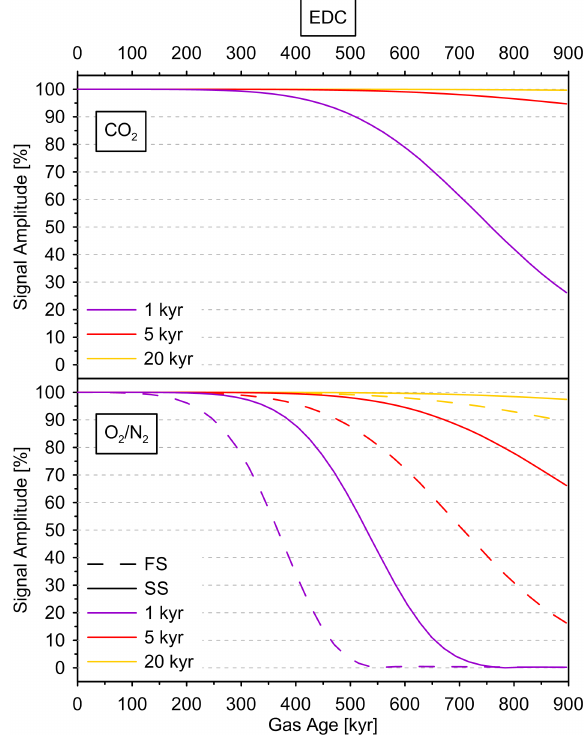
27624 Fig. 7. Simulated amplitude dampening of CO 2 concentration (top) and O 2 /N 2 ratio (bottom) signals for the EDC ice flow and temper- ature profile (Fig. 1). The different coloured lines show the results for different periods of the signal as indicated by the